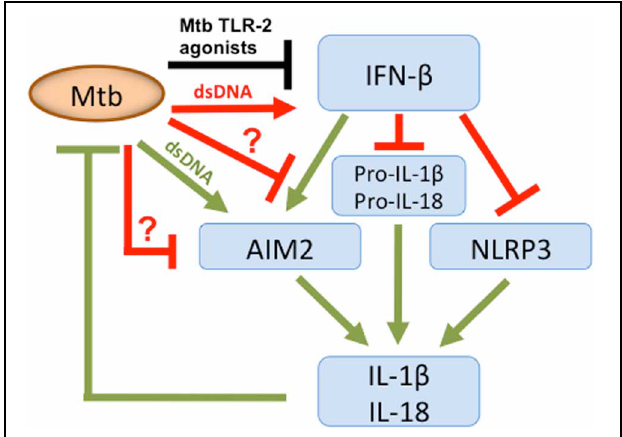
FIGURE 1 | Overview of Mtb host cell inflammasome interactions. Mtb secretes dsDNA, which induces IFN- β production but also expresses TLR-2 agonists that inhibit. Nevertheless, overall there is an increase in IFN- β , which limits pro-IL-1 β and pro-IL-18 transcription and has opposing effects on inflammasome activation. IFN- β inhibits the NLRP3-inflammasome but stimulates the AIM2-inflammasome. To limit AIM2-mediated IL-1 β production, Mtb secretes putative effector(s) via its ESX-1 system, as indicated by “ ? .” They either directly or indirectly inhibit the AIM2-inflammasome resulting in diminished caspase-1 activation and subsequent reduction in IL-1 β and IL-18 production. Green color denotes connections that are beneficial to the host; those in red are beneficial to the pathogen and in black those where this is